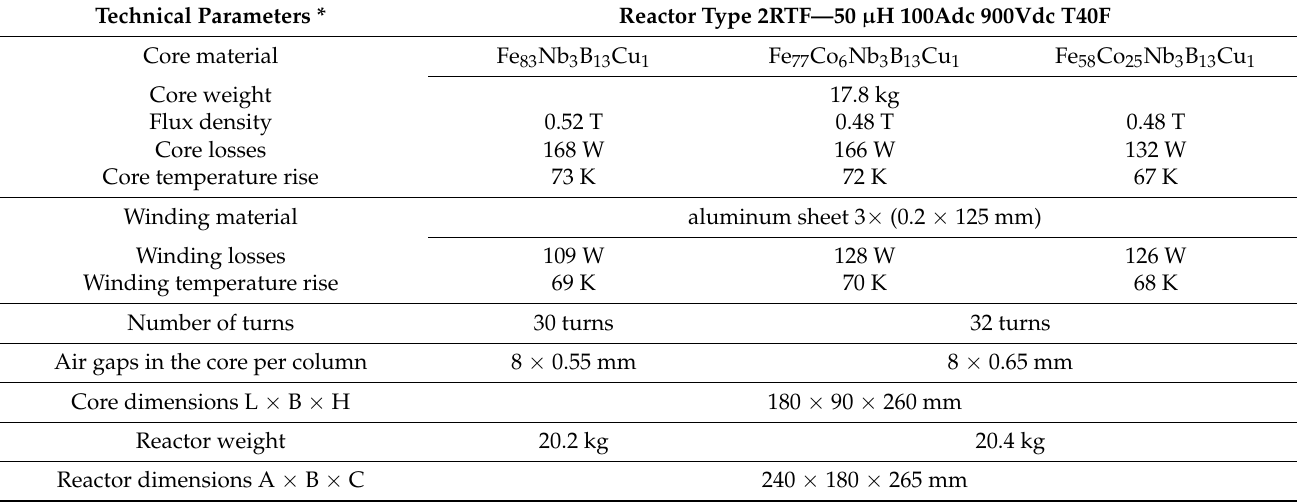
Table 4. Technical data of chokes obtained in computational